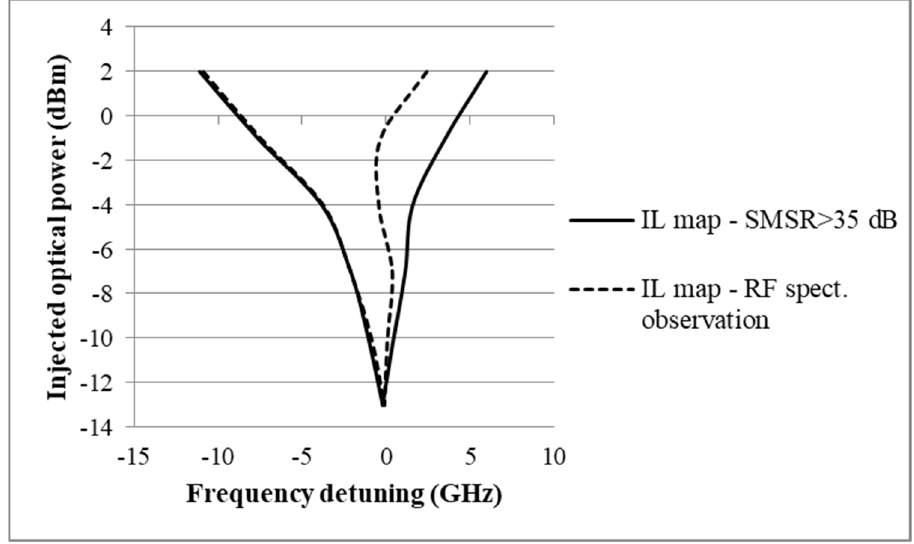
Figure 10. Measured stable-locking regions of injection-locked FP laser with two methods: SMSR higher than 35 dB (solid line) and by observing RF spectrum (dashed line).